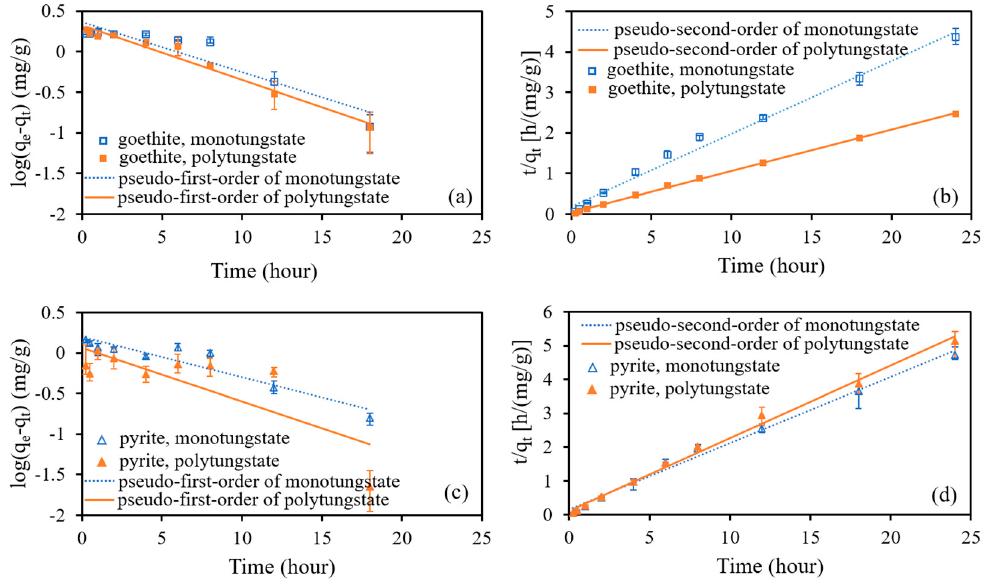
Figure 3. Adsorption of monotungstate and polytungstate onto goethite ( a ) and pyrite ( b ) as a function of contact time.